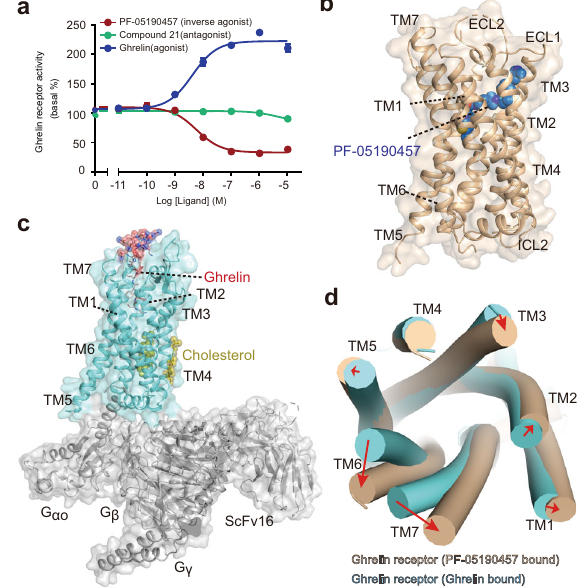
Fig. 1 Overall structures of ghrelin receptors bound to inverse agonist and agonist. a Dose-dependent responses of endogenous agonist ghrelin, inverse agonist PF-05190457 and antagonist compound 21 containing 10 nM ghrelin peptide at wild-type ghrelin receptor measured by cellular IP1 accumulation assays. The ghrelin peptide represents high activation potency as a full agonist, and PF-05190457 functions as an inverse agonist to signi fi cantly reduce basal activity (dotted line). Data represent the mean ± SEM from n = 3 biologically independent experiments performed in triplicate. b View from within the plane of the membrane. The inverse agonist-bound ghrelin receptor is represented as a wheat cartoon, and PF- 05190457 is shown as a marine blue sphere. Cryo-EM structure of the agonist ghrelin-bound ghrelin receptor-G α o1-scFv16 complex. c Ghrelin peptides and receptors are shown as deep salmon spheres and aquamarine cartoons, respectively. The Go heterotrimer and scFv16 are shown in the gray cartoon. d View from the extracellular side of the membrane. The structural comparison of inverse agonist-bound (wheat) with agonist- bound structures (aquamarine) reveals that notable outward movements occur in the extracellular ends of TM